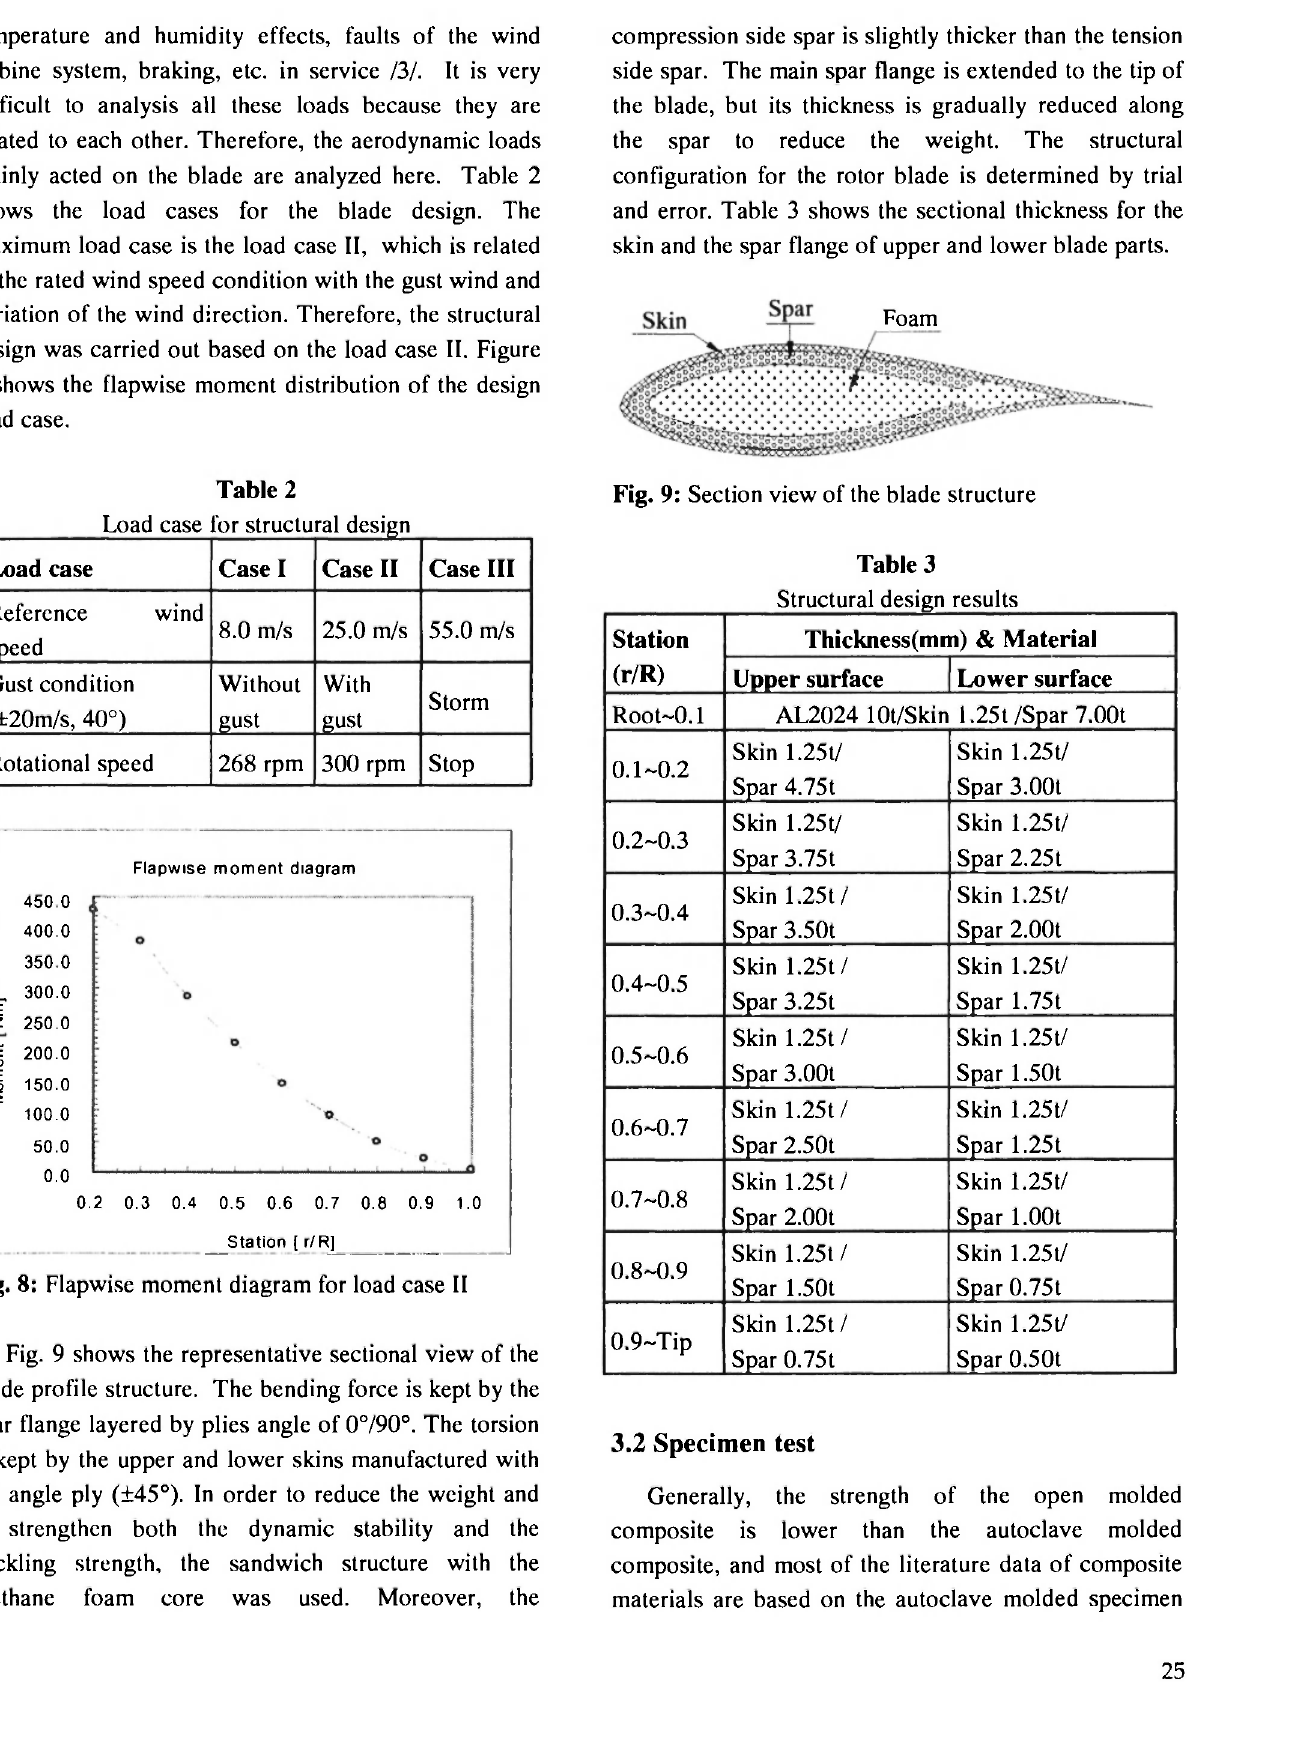
Fig. 8: Flapwise moment diagram for load case II